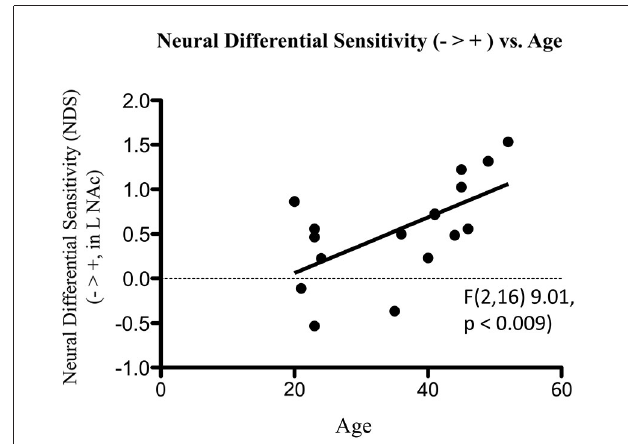
FIGURE 7 | Association of NDS from BOLD signal collected by fMRI with age . The line of best fit is shown from this